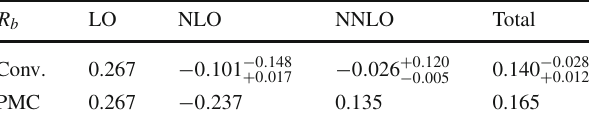
Table 2 Contributions from each loop terms for R b up to NNLO level under conventional (Conv.) and PMC scale-setting approaches, respec- tively. The PMC predictions are scale invariant, and the Conv. predic- tions are highly scale dependent, whose center values are for μ r = m b , μ (cid:12) = m μ ∈ [ 1 GeV , 2 m ] b . and the errors are for r b